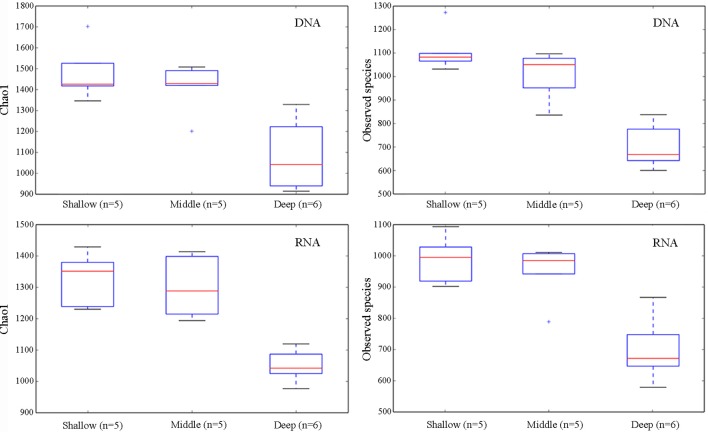
Alpha-diversity measures (Chao1 and Observed species) for the pooled samples from the two sampling sites grouped by water depths, shallow (5, 25, and 75 m), middle (200, 300, and 500 m), and deep (1,000, 1,500, 2,000, and 3,900 m), revealed by DNA and RNA, respectively. The line in each box plot indicates the median, the box delimits the 25th and 75th percentile, and the whisker is the range.